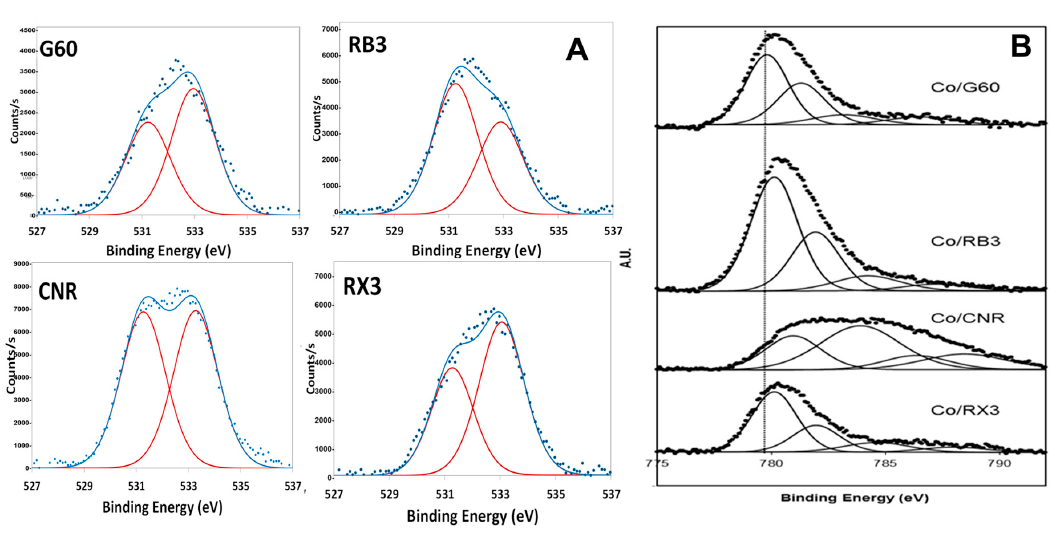
Figure 4. ( A ) O1s BE spectra by XPS of the supports: G60, RB3, RX3 and CNR; ( B ) XPS spectra for BE Co 2p 3/2 of the catalysts: Co/G60, Co/RB3, Co/RX3 and Co/CNR. Table 2. Total area of CO, CO 2 and O 2 obtained by TGA/MS deconvolution of the AC supports. Sample